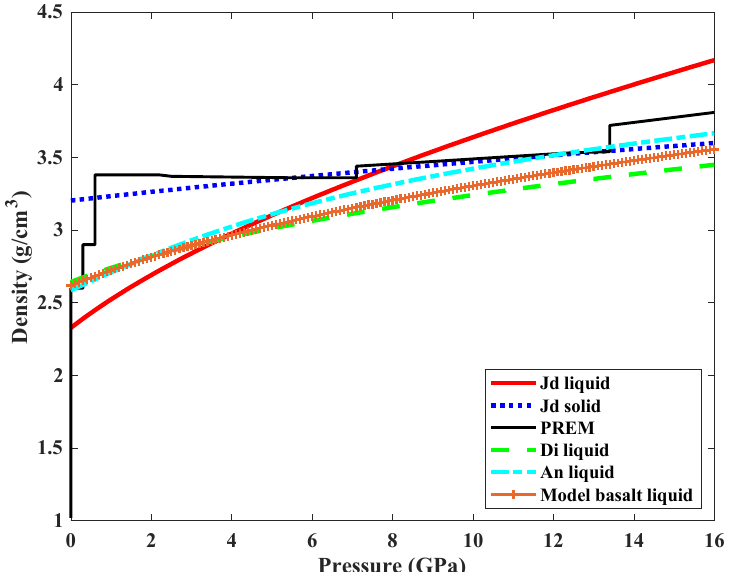
Figure 6. Comparison of the density profile of jadeite melt obtained in this study with that of jadeite solid [22], PREM (Preliminary Reference Earth Model) model [65] and Di, An, model basalt (Di 64 An 36 ) melts [30]. The Jd melt and solid are compared at 1673 K isotherm, while the Di, An and model basalt liquids from shock-wave studies are along their respective adiabats with a potential temperature of 1673 K. The shaded area represents the uncertainty in the compression curve for jadeite melt.